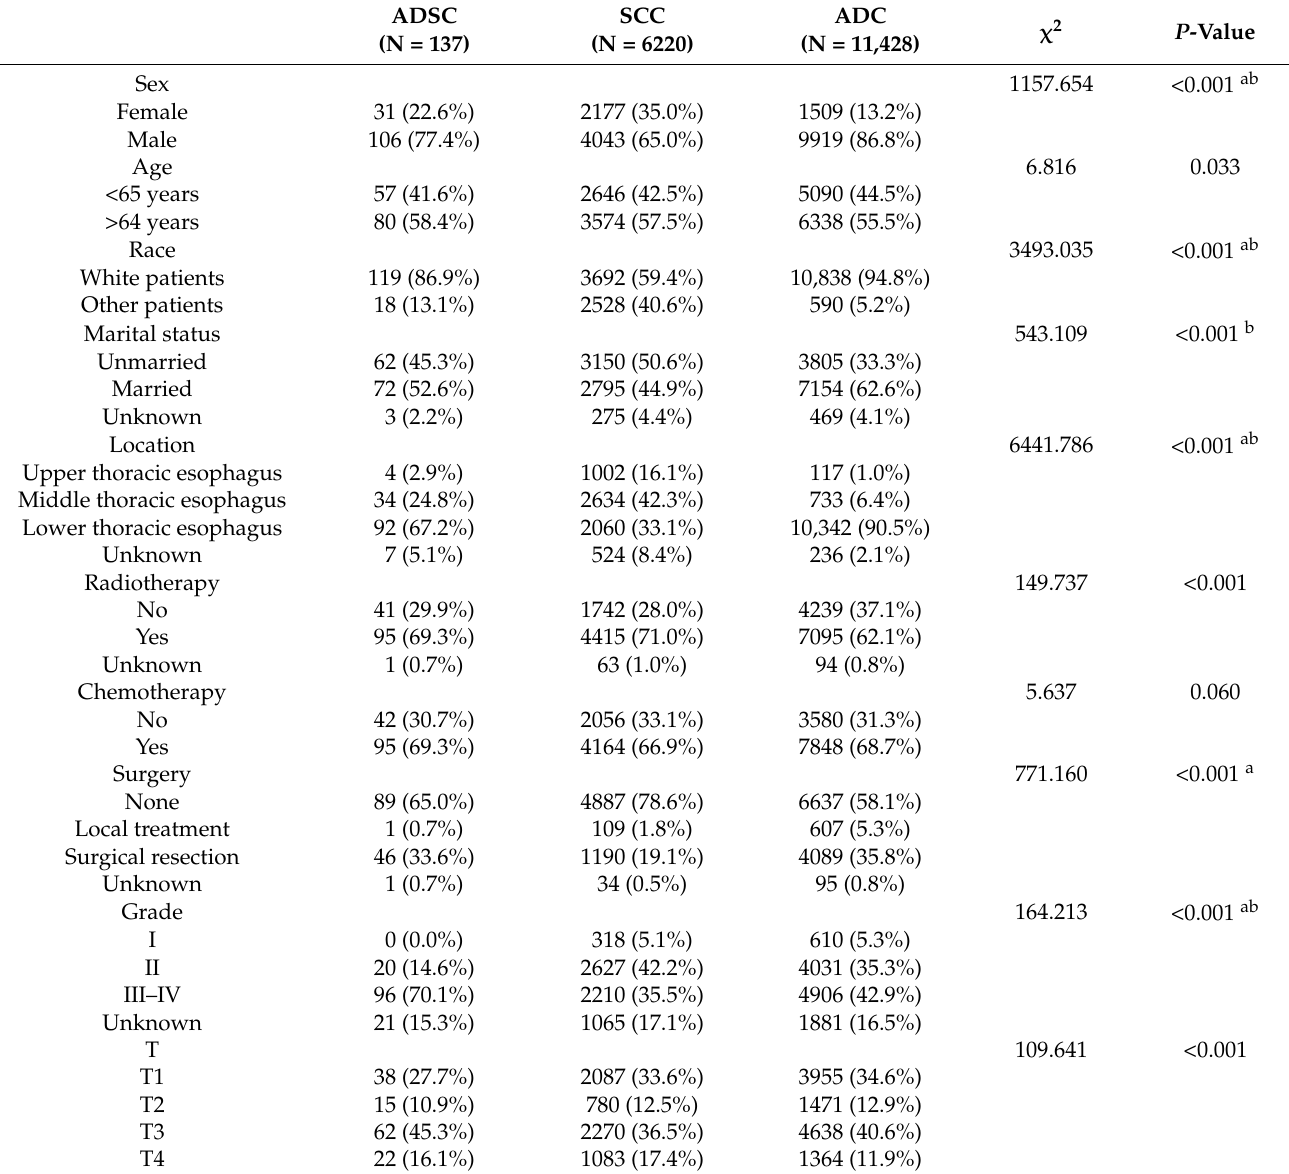
Table 1. Baseline characteristics of three different pathological types of esophageal cancer in the SEER database (N